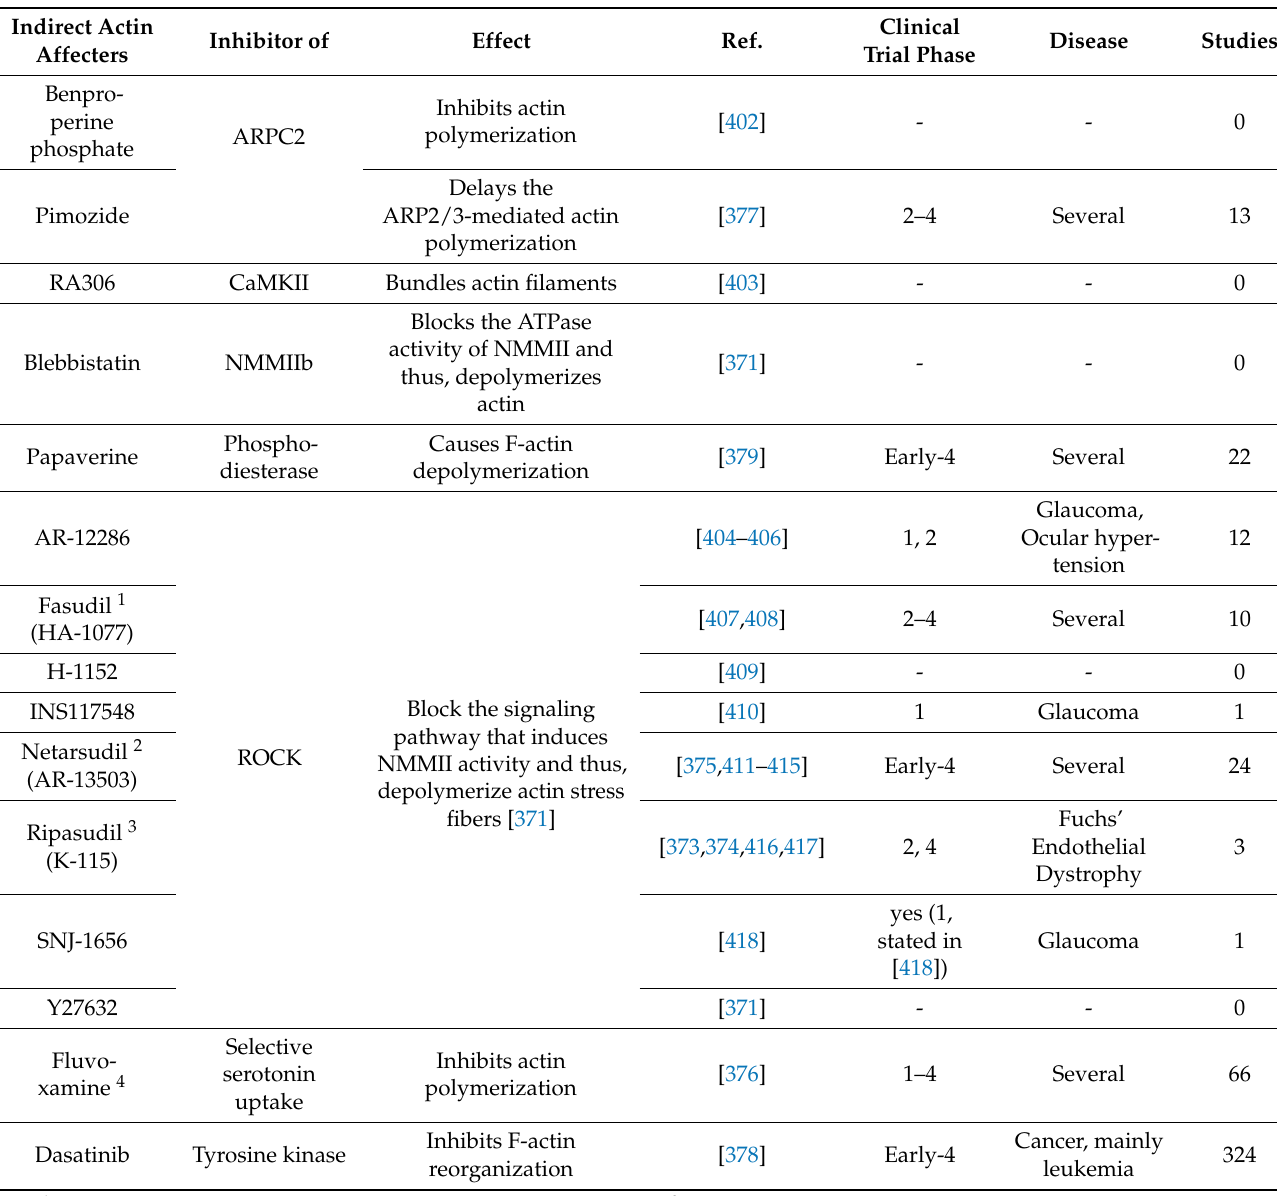
Table 4. The effects of drugs that indirectly affect the actin cytoskeleton and information on tests in clinical trials. The cited references describe the effect on actin; information on clinical trials was collected from clinicaltrials.gov (accessed on 27 January